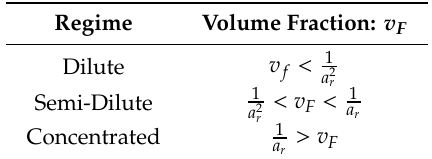
Table 1. Classification of fluid–fiber